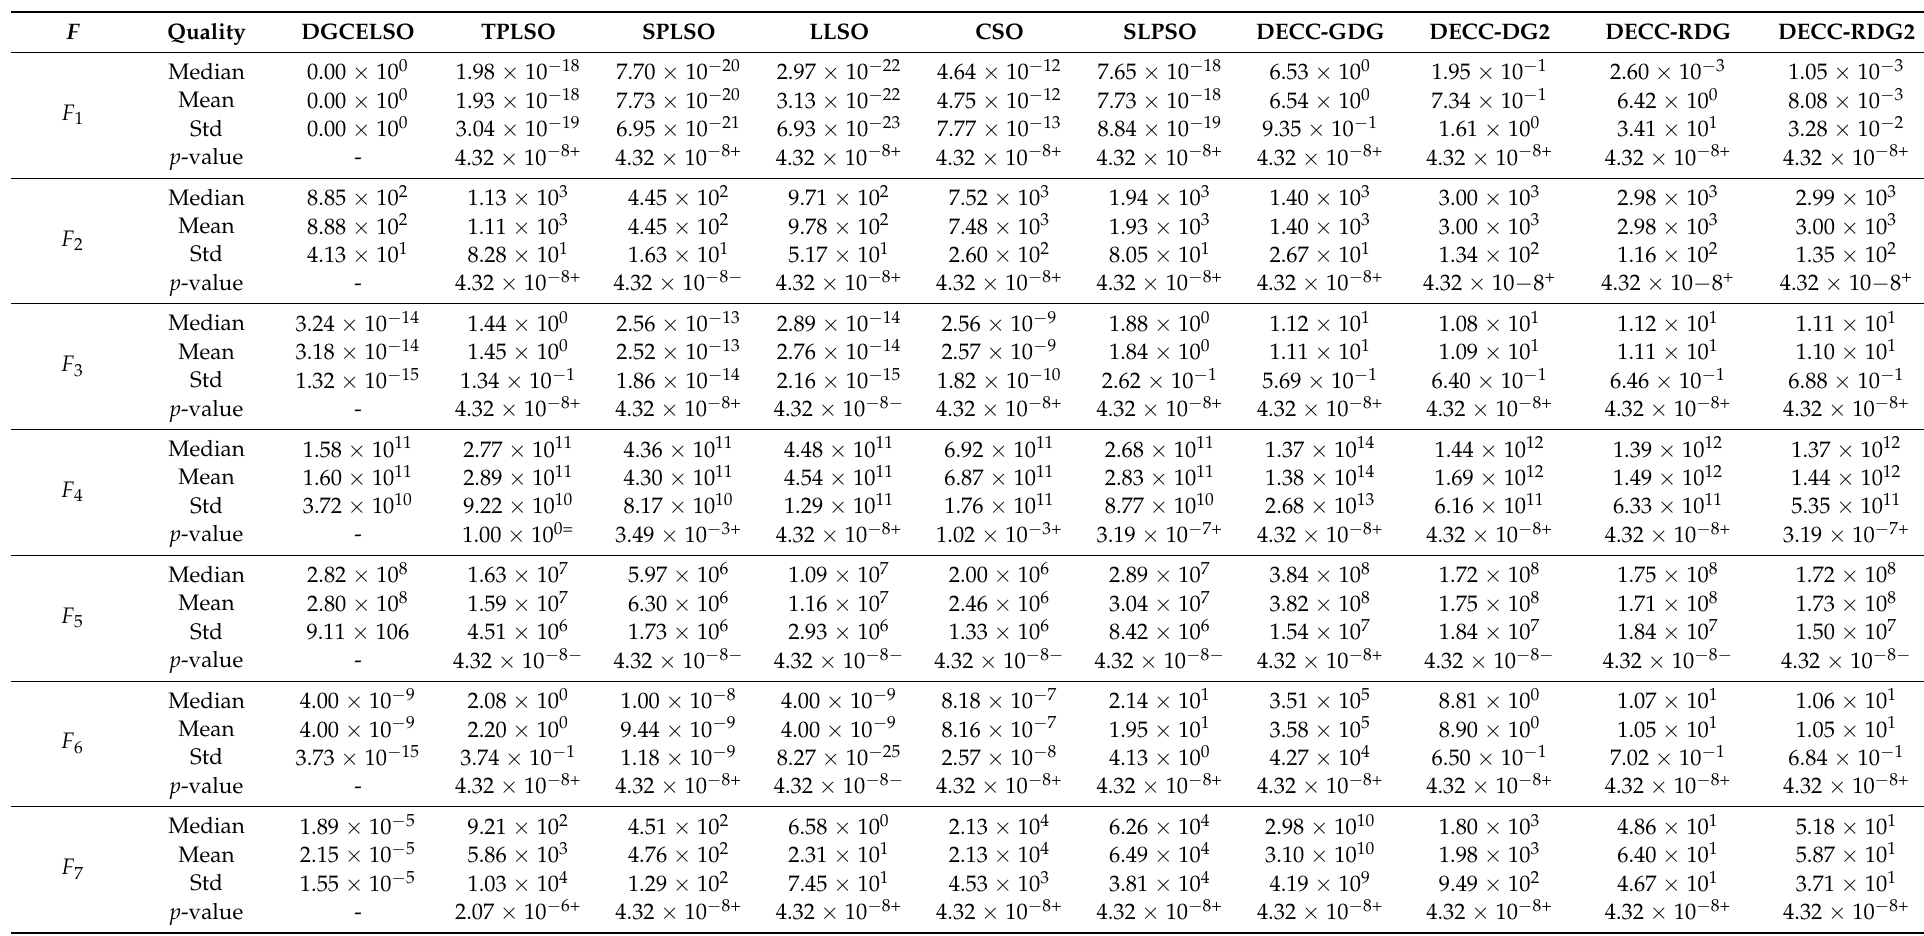
Table 2. Fitness comparison between DECELSO and the compared algorithms on the 1000-D CEC’2010 problems with 3 × 10 6 fitness